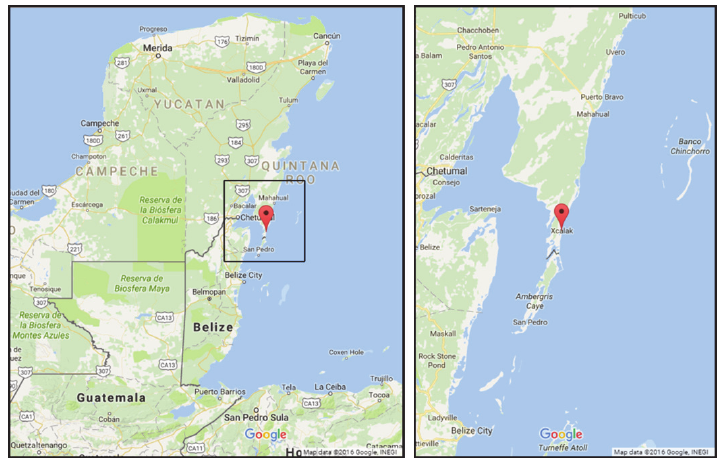
Figure 1: Map showing the geographical position of the studied